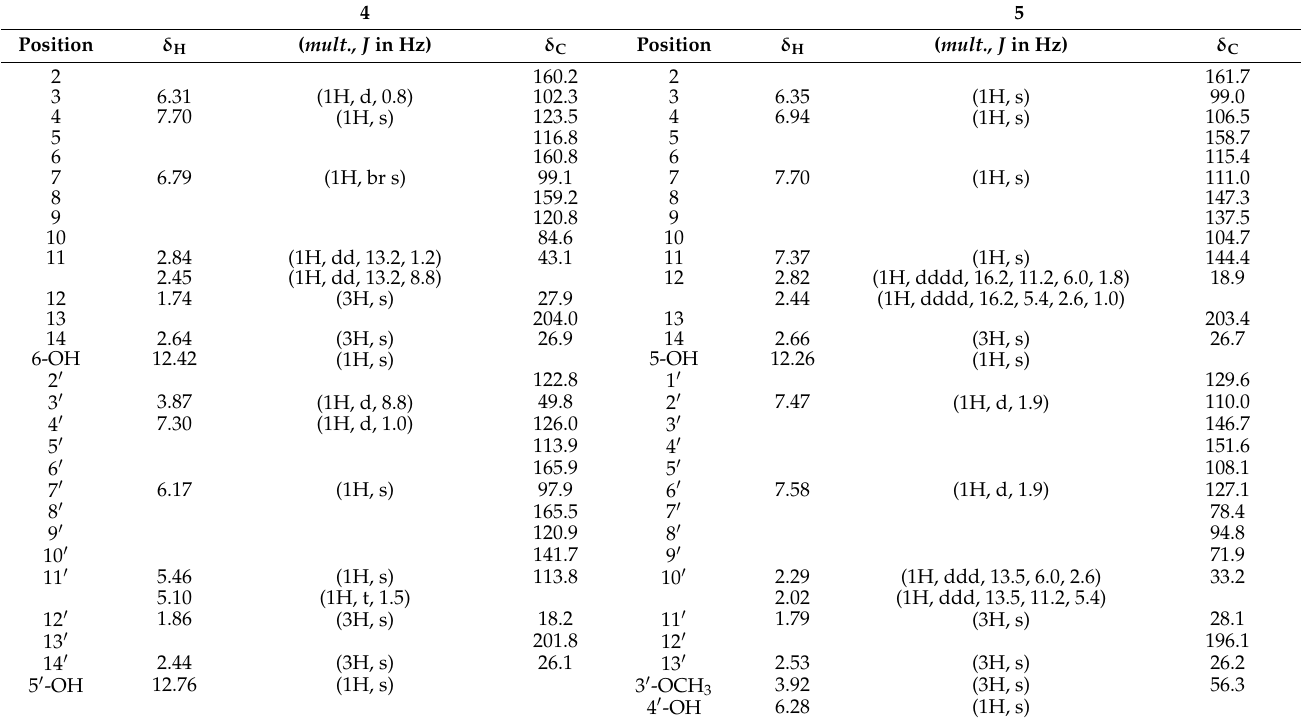
Table 2. 1 H (500 MHz) and 13 C (126 MHz) NMR data of 4 and 5 in CDCl 3